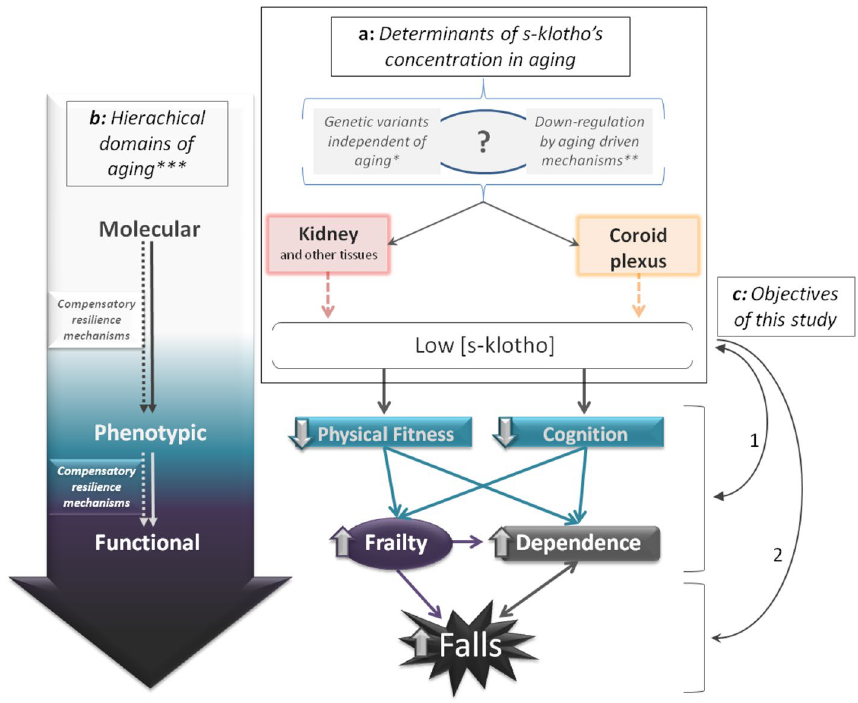
Figure 1. ( a ) Schematic representation of the determinants of s-klotho’s concentration in aging * 7 , ** 8,9 and ( b ) the hierarchical domains of aging *** 42 . ( c ) The objectives of this study: to ascertain the association of